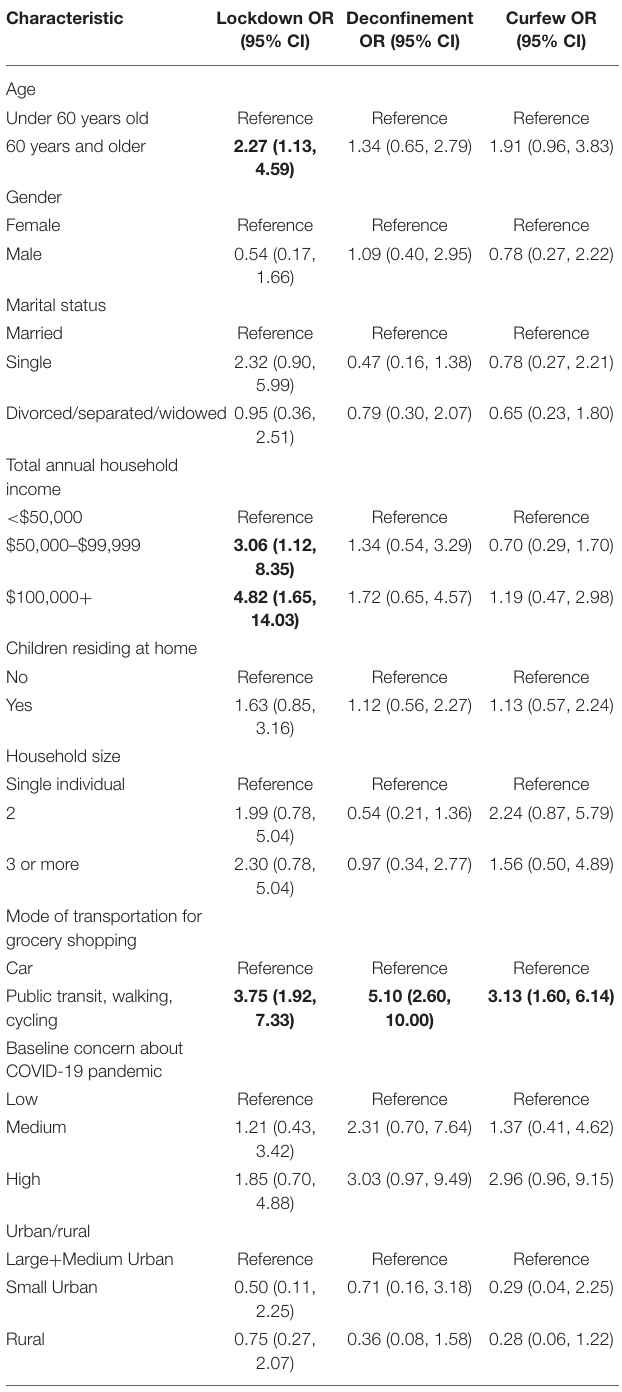
TABLE 2 | Characteristics of regular users of no-contact grocery methods ( n =